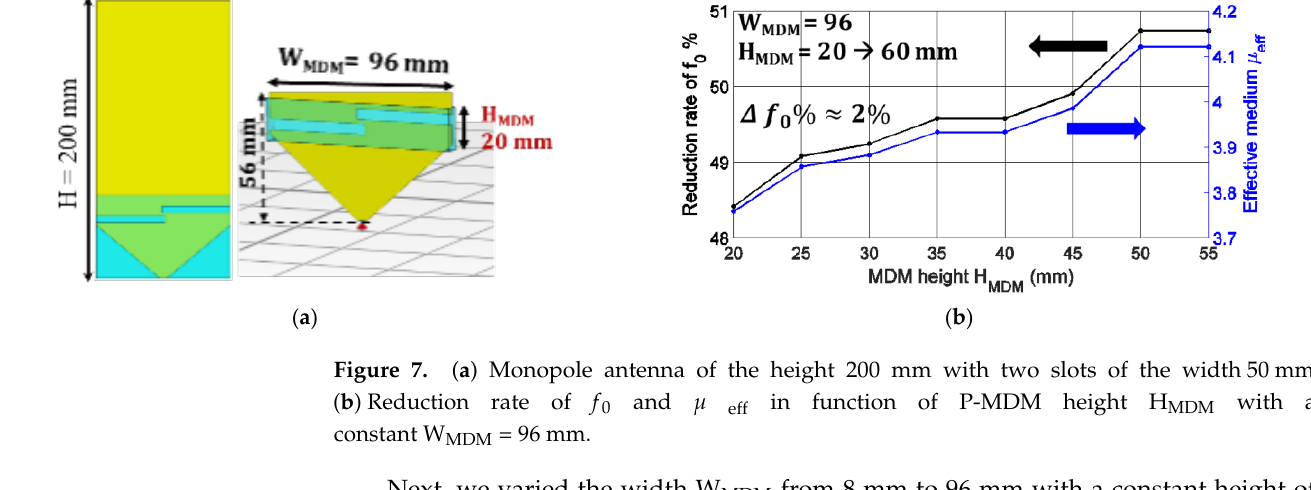
Figure 7. ( a ) Monopole antenna of the height 200 mm with two slots of the width 50 mm. ( b ) Reduc- tion rate of f 0 and μ eff in function of P-MDM height H MDM with a constant WMDM = 96 mm. 49% for the maximum width W MDM = 96 mm.